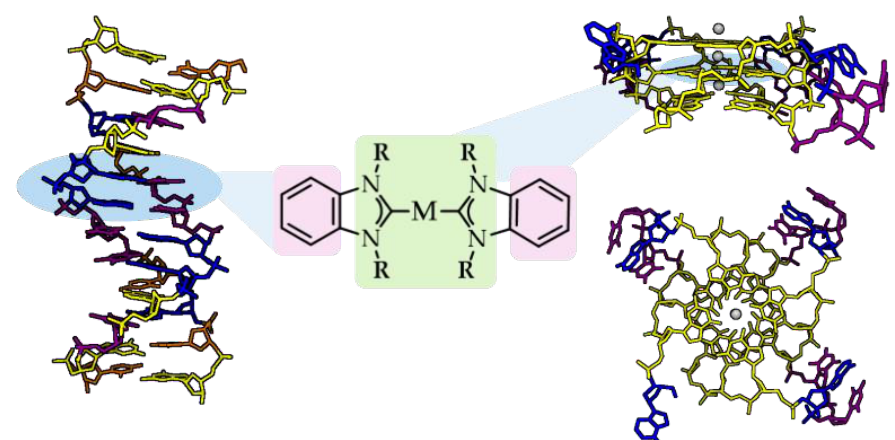
Figure 7. Rational design of ligand candidates intercalating with dsDNA (PDB code 1D28) and G-quadruplex motifs (PDB code 1KF1) via π -stacking of planar aromatic moieties (pink) and/or contributing R wingtips (light green). Created with BioRender.com.